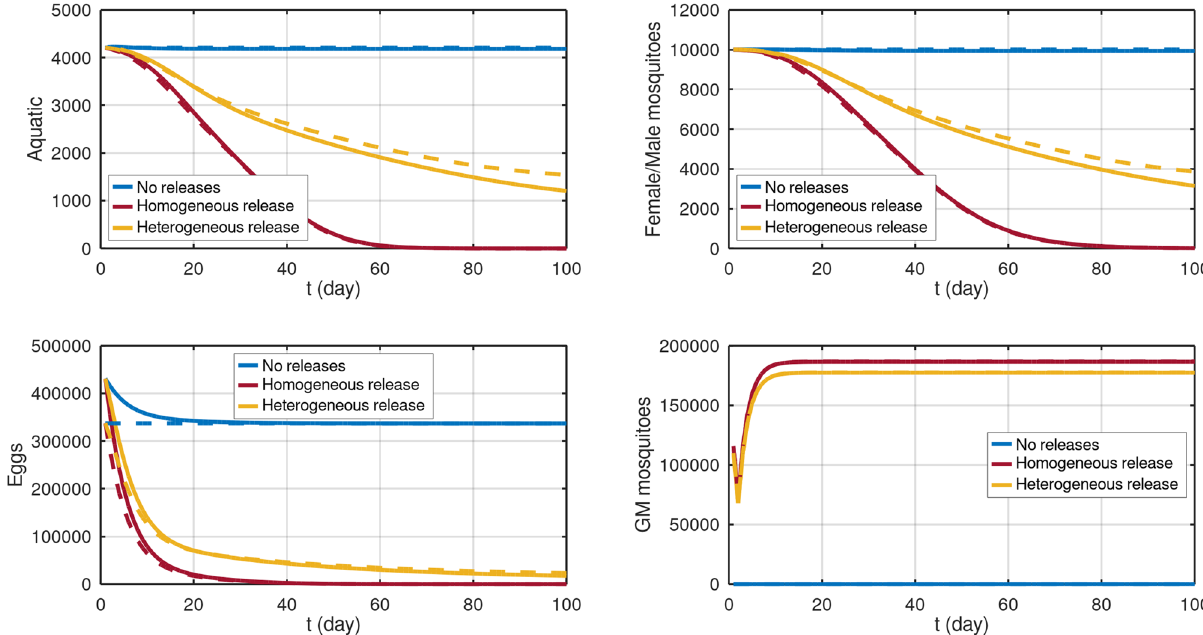
Figure 4. Populations density in different release strategies. The continuous lines represent the dynamics on a heterogeneous map (carrying capacity depend on location), and the dotted lines refer to the homogeneous map (same carrying capacity on all map). The homogeneous release considers that the GM mosquitoes are uniformly released on the map. The heterogeneous release means that this release happens inside the region highlighted in the left panel of Figure 3. Both strategies release the same amount of